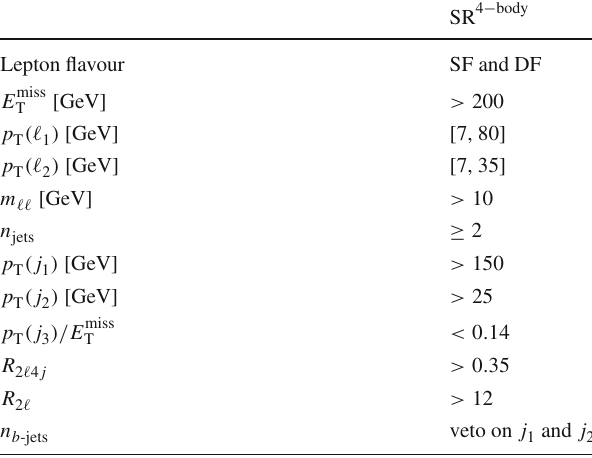
Table 4 Four-body selection signal region